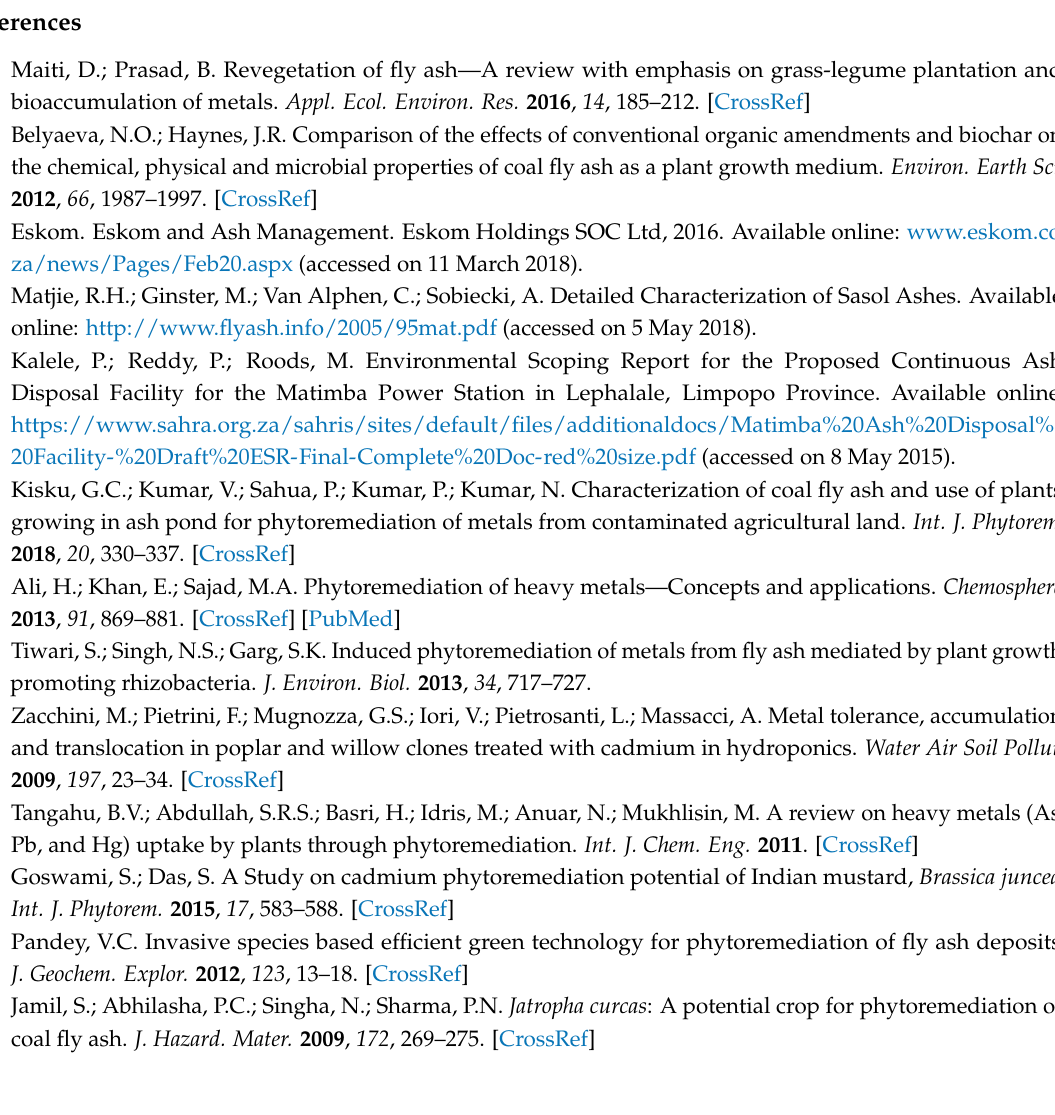
Table S5: Chemical-element concentrations in leachates obtained from CFA pots growing B. juncea ., Table